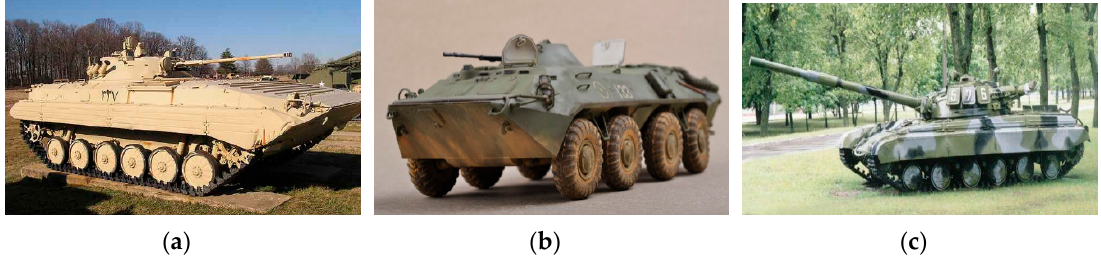
Figure 6. Optical images of three targets. ( a ) BMP2, ( b ) BTR70, ( c ) T72.